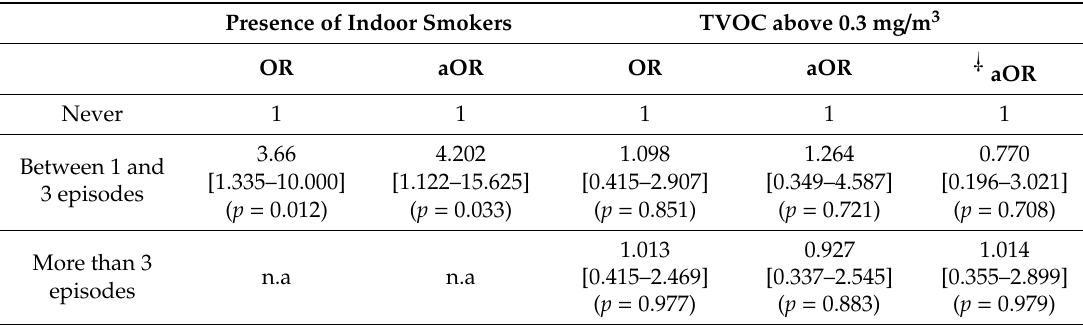
Table 3. Indoor air quality parameters, outdoor air quality parameters, and indoor/outdoor (I/O) ratios. (Legend: n = 131, except for § where n = 128 valid cases; ⸸ where n = 109 valid cases; ¥ where n = 121 valid